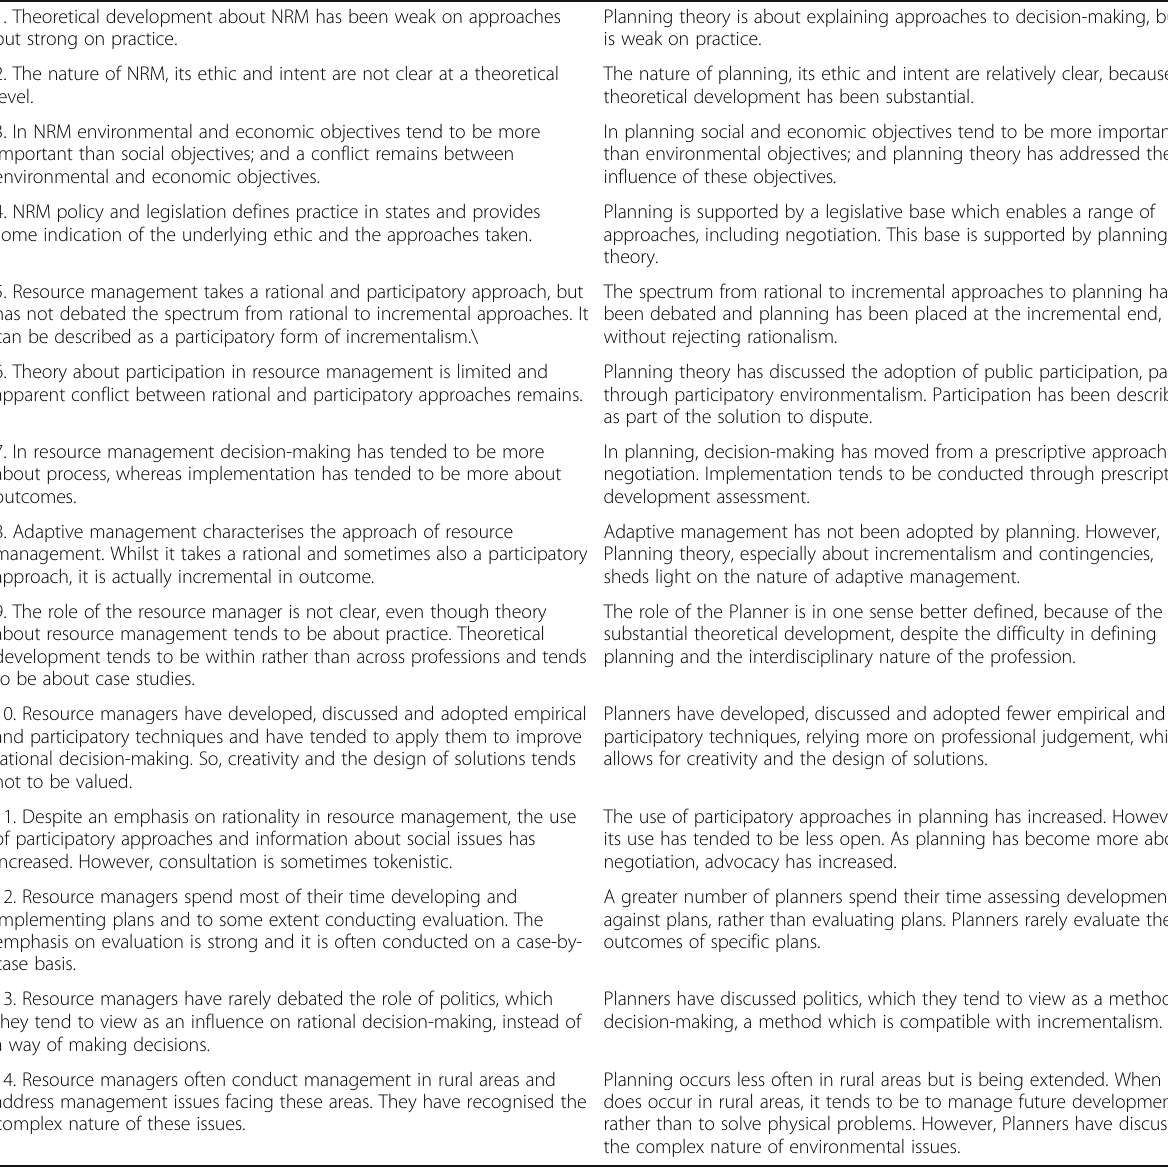
Table 1 Contrasts between the NRM and planning professions to aid in ongoing cross-fertilization Resource management